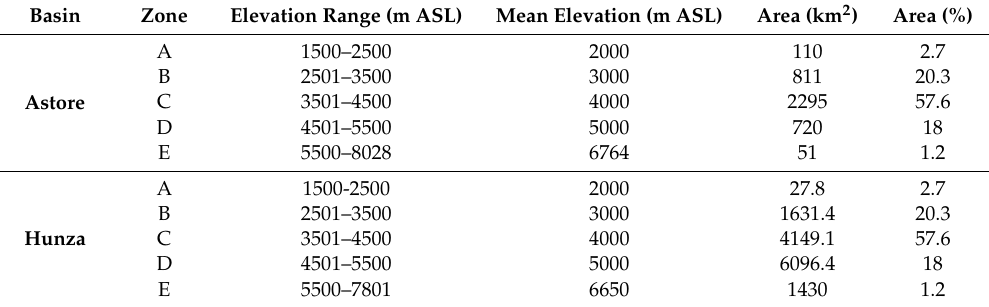
Table 3. Characteristics of elevation zones estimated from DEM for Astore and Hunza basin for the zone-wise application of